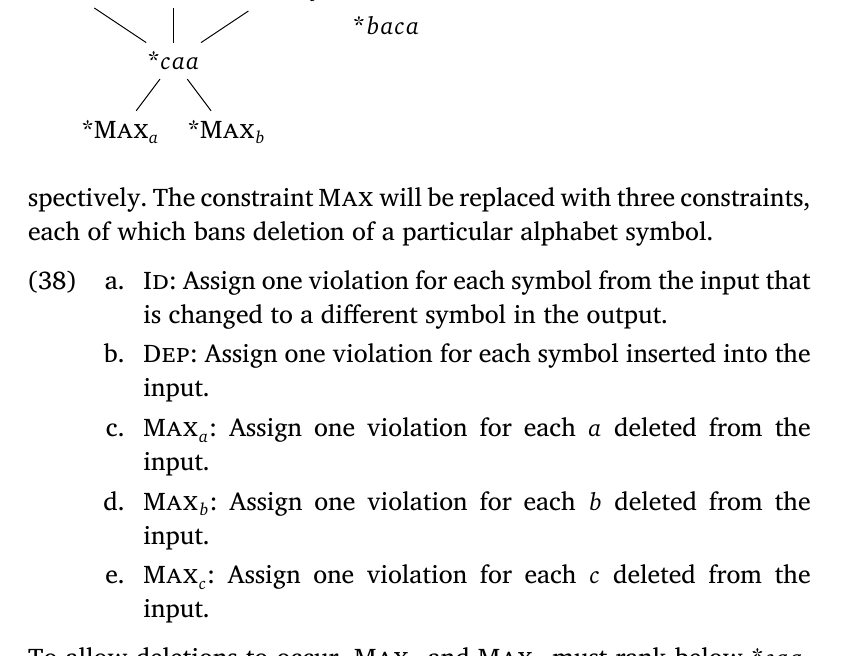
Figure 4: Required ranking relations among